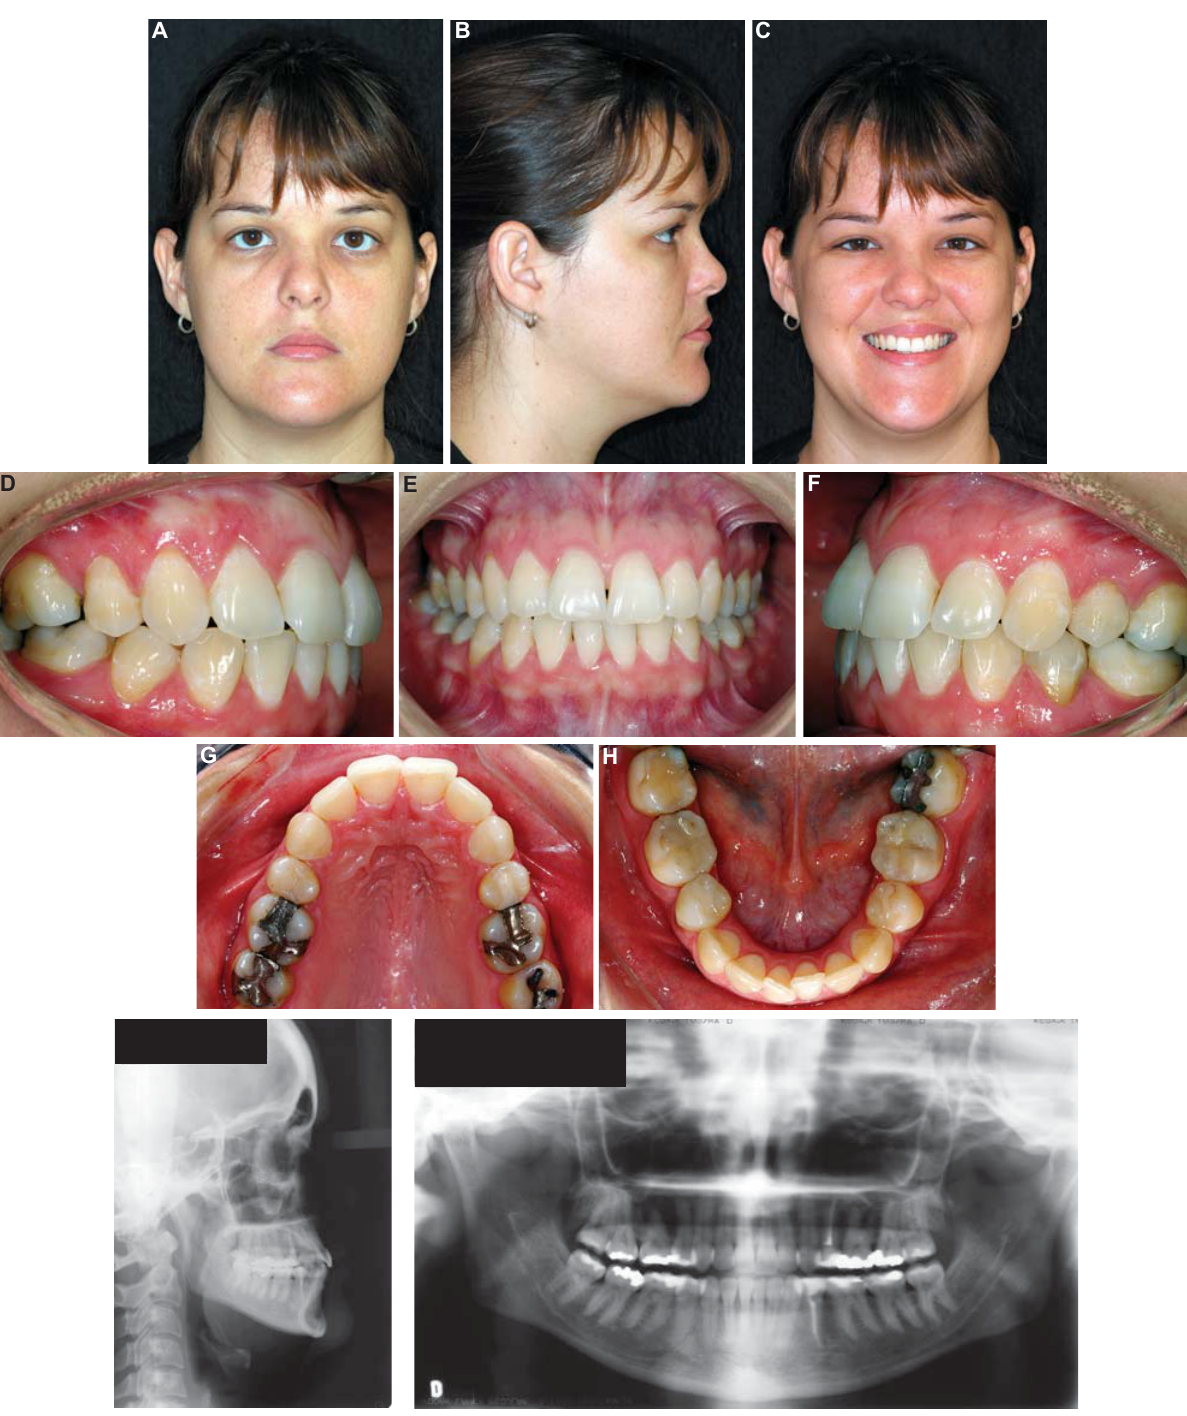
Figure 8- Twenty-year follow-up after the interceptive stage: extraoral (A-C) and intraoral (D-H) photographs, lateral cephalogram (I), panoramic radiograph (J) (the parents authorized the publication of these